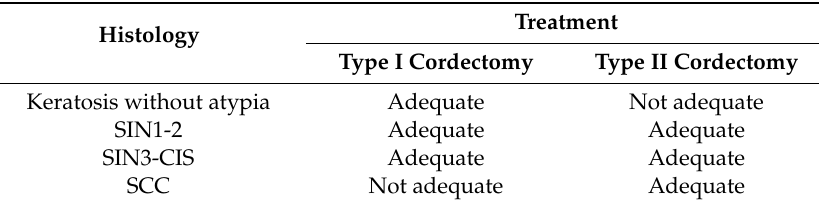
Table 1. Definition of adequacy of treatment.